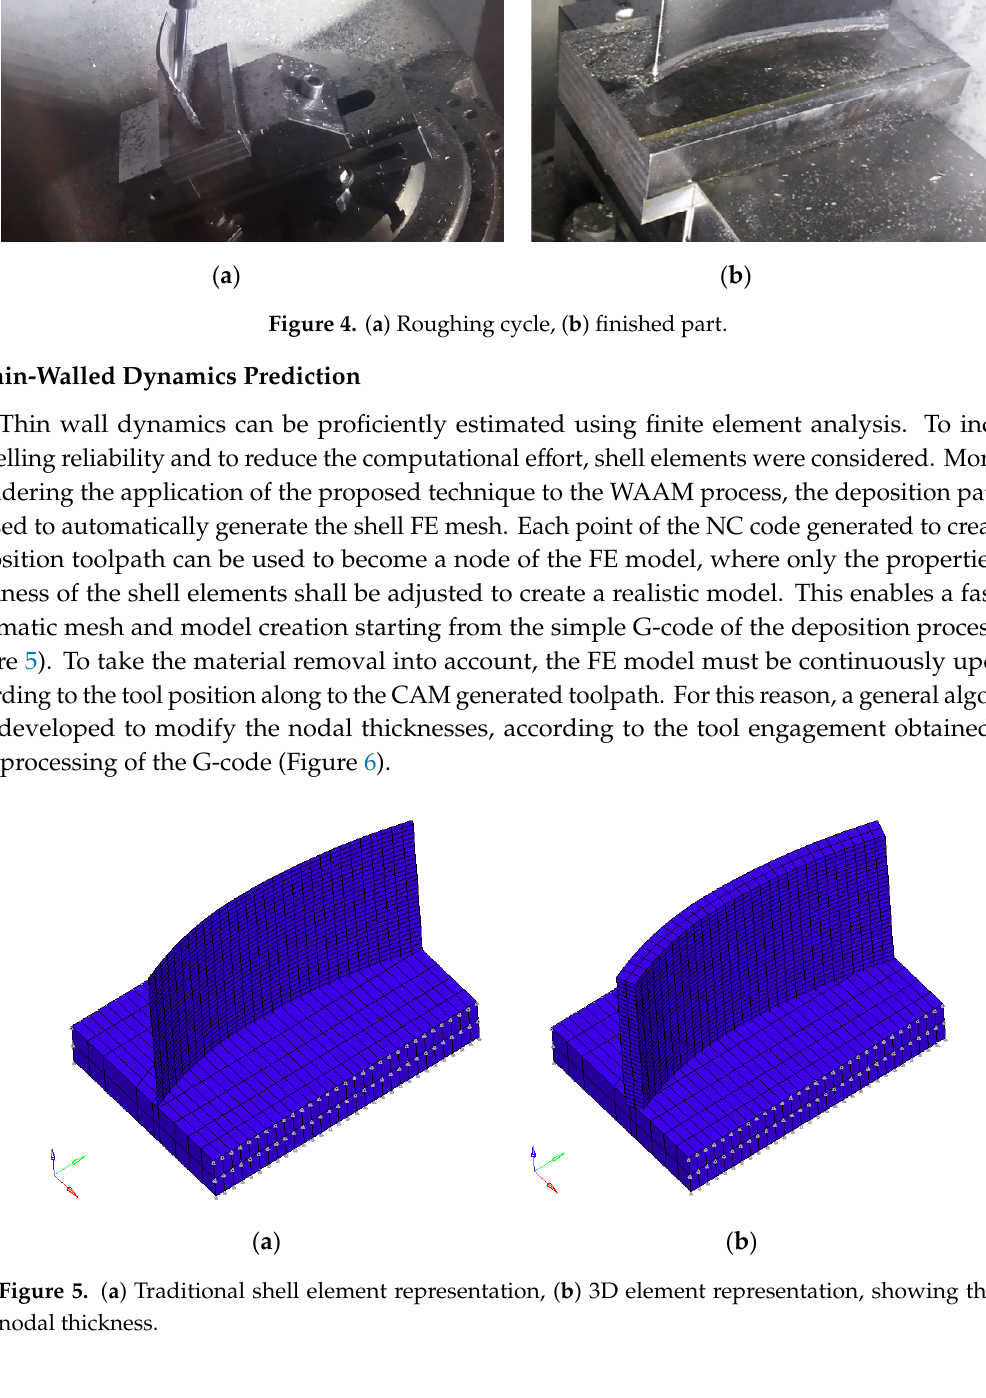
nodal thickness. nodal